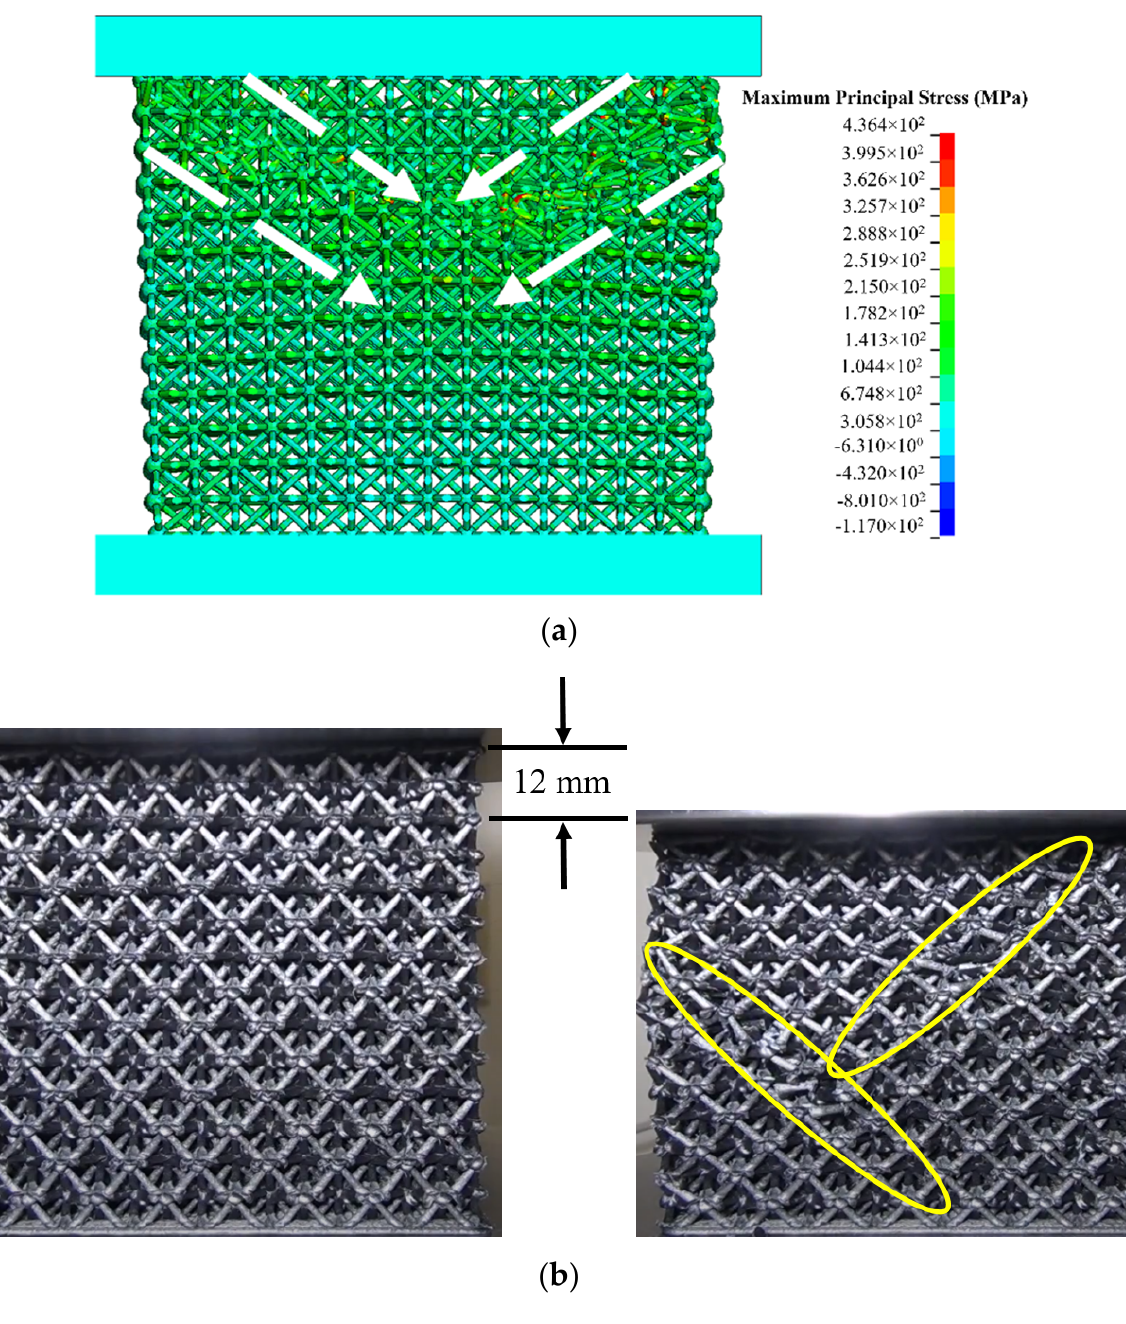
Figure 19. ( a ) First Principal Stress plot in the octet truss at the onset of failure; ( b ) Lattice structure prior to compressive load (left) and lattice structure after 12 mm of compression.